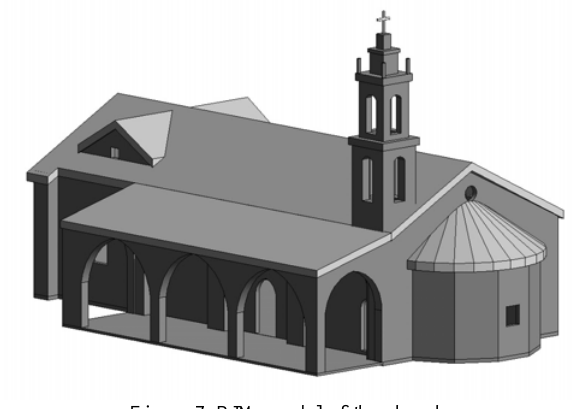
Figure 7. BIM model of the